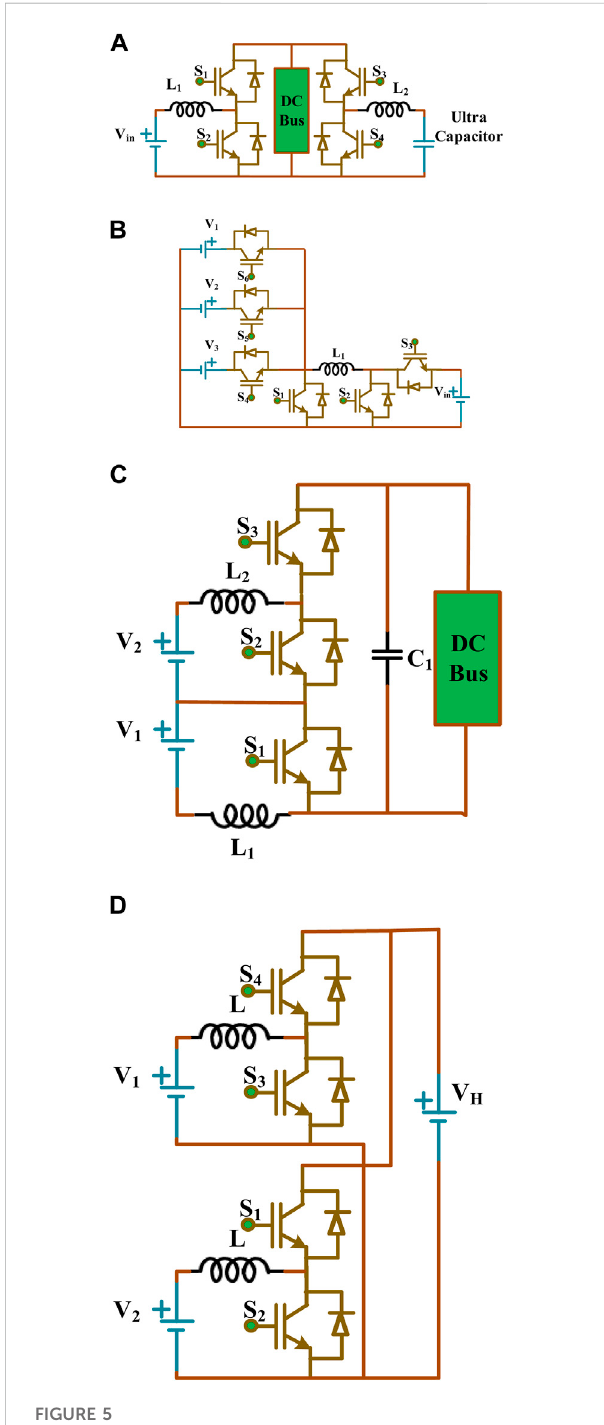
FIGURE 5 Non-isolated multi-input converters (A) buck-boost (B) DC-DC (C) cascaded (D)